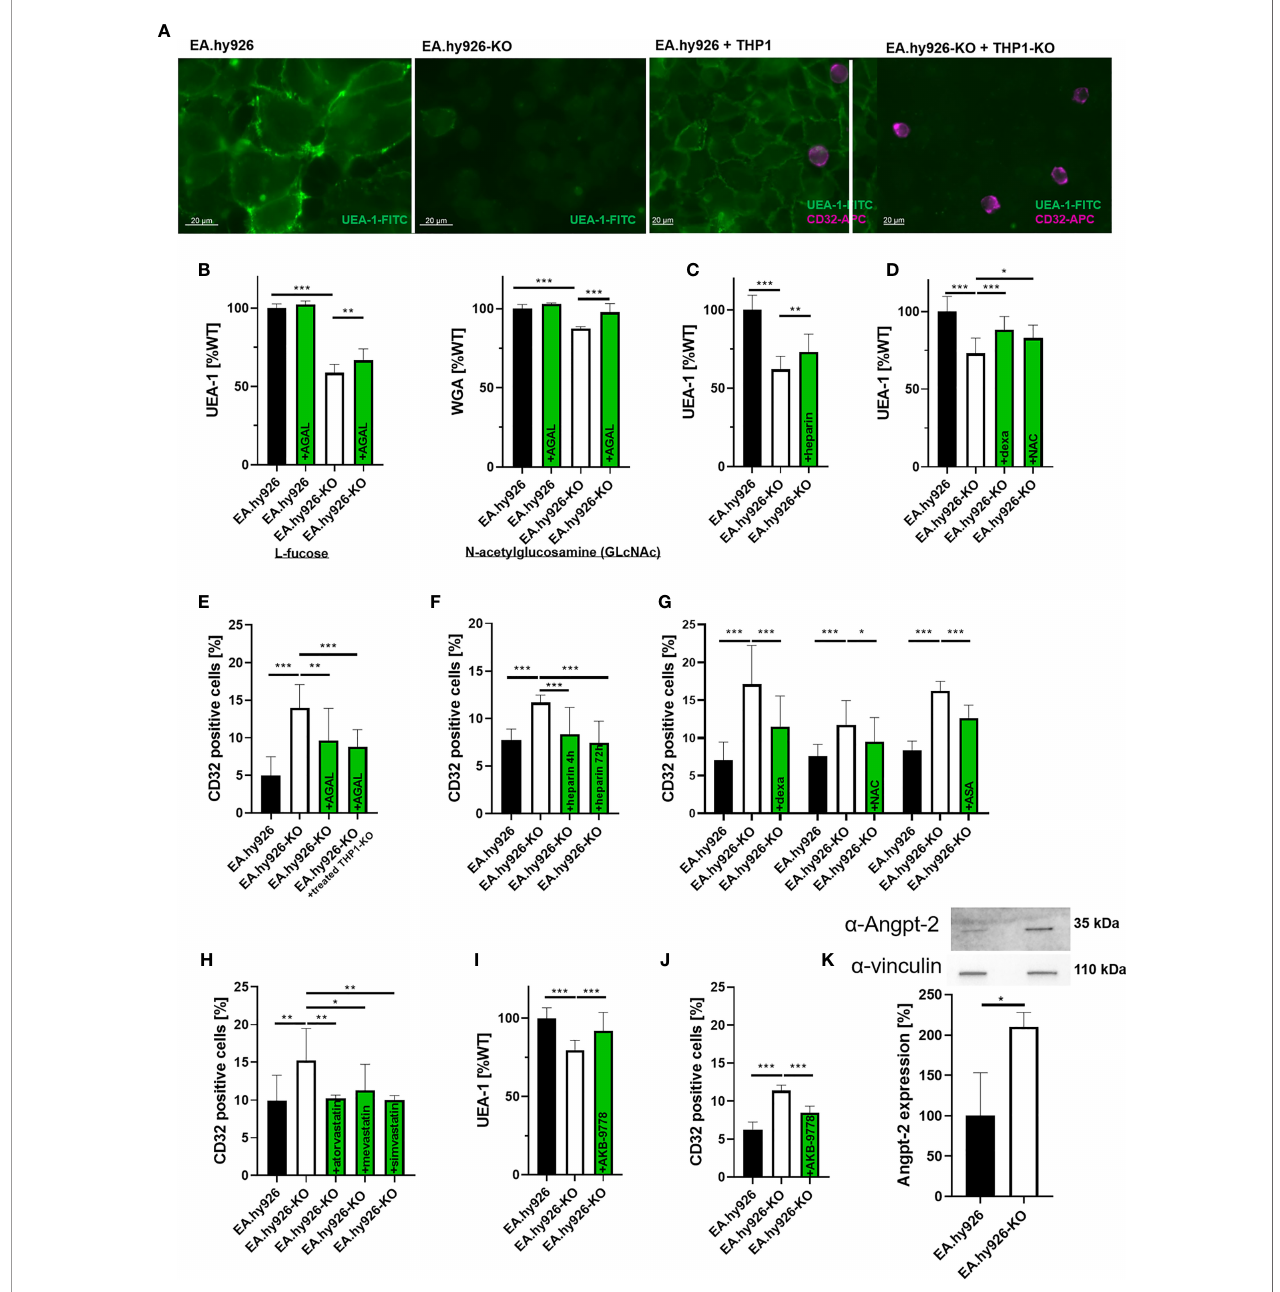
FIGURE 2 | In vitro characterization of the endothelial glycocalyx in Fabry disease. (A) L-fucose stainings (green) of wild-type and AGAL-de fi cient EA.hy926-KO cells (left) and detection of adherent monocytes with CD32-APC (violet) antibodies (right). (B) L-fucose (UEA-1) and N-acetylglucosamine (WGA) stainings of wild-type and AGAL-de fi cient EA.hy926 cells revealed less glycocalyx in AGAL-de fi cient cells, which could be improved by 20 mg/ml agalsidase-beta (AGAL) treatment for 48 hours. (C) Heparin treatment (0.4 U/ml for 48 h), (D) dexamethasone (dexa, 60 µM) and N-acetylcysteine (NAC) (20 nM) treatment of AGAL-de fi cient cells protected glycocalyx. (E) THP1 adhesion was increased in an AGAL-de fi cient background and decreased after treatment with 20 mg/ml agalsidase-beta for 96 h. (F) Heparin (0.4 U/ml) and (G) dexamethasone (60 µM), NAC (20 nM), and acetylsalicyl acid (ASA, 100 µM) treatment for 72 h decreased monocyte adhesion on AGAL-de fi cient EA.hy926 cells. (H) Statins (all 1 µM for 96 h) reduced monocyte adhesion in an AGAL-de fi cient background to wild-type level. Treatment with the Tie2 activator AKB-9778 resulted in (I) increased glycocalyx thickness and (J) reduced monocyte adhesion in an AGAL-de fi cient background. (K) Angiopoietin-2 (Angpt-2) expression was increased in AGAL-de fi cient endothelial EA.hy926-KO cells. Experiments in (B, D, I) were quanti fi ed in a plate reader. Experiments in (E, H, J) were quanti fi ed by fl ow cytometry. AGAL, a -galactosidase A, UEA-1, Ulex europaeus agglutinin I, WGA, Wheat germ agglutinin. *p < 0.05, **p < 0.01, **p < 0.001 determined by Kruskal-Wallis test or One-Way ANOVA (B – J) or students t test (K)